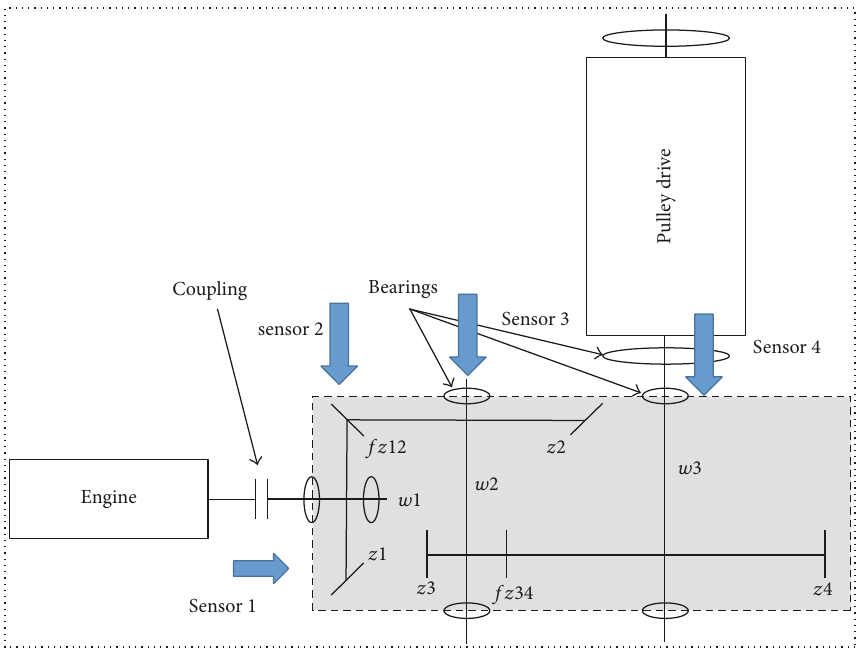
Figure 1: Scheme of the gearbox.